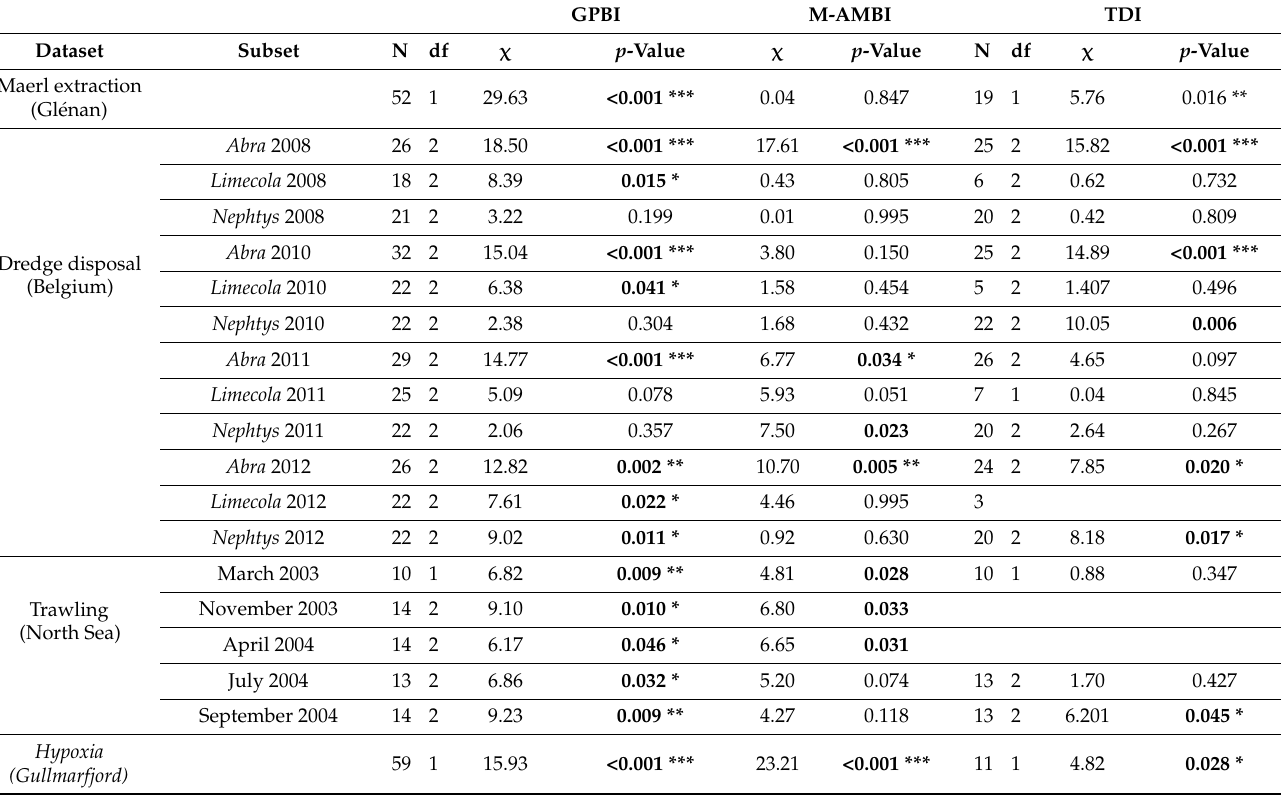
Table 2. Kruskal–Wallis rank tests, testing the null hypothesis of no median difference in GPBI, M-AMBI, or TDI between groups of pressure. N stands for the number of sampling occasions taken into account and considers only stations with a minimum of 50% of abundance relating to functional traits (TDI), and df stands for degree of freedom. N, chi-square, and p -values are given for the three indices. Significant differences are marked in bold when the null hypothesis was rejected ( p -value < 0.05) and (*) corresponds to p < 0.05, (**) to p < 0.01 and (***) to p < 0.001 only when the EcoQ assessed by the index indicates decreasing quality with increasing